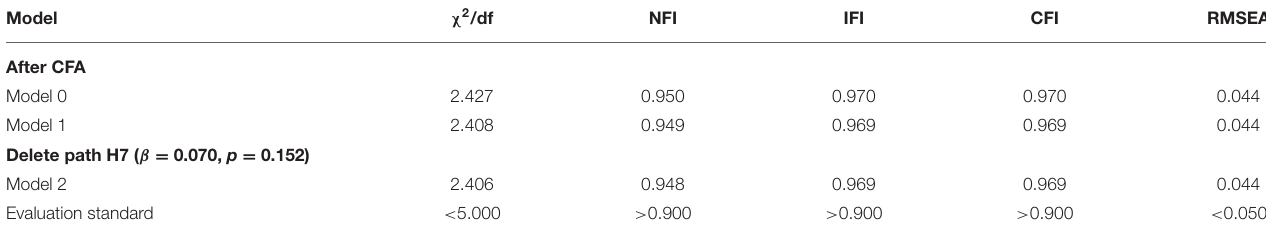
TABLE 4 | Structural equation model fitting index.